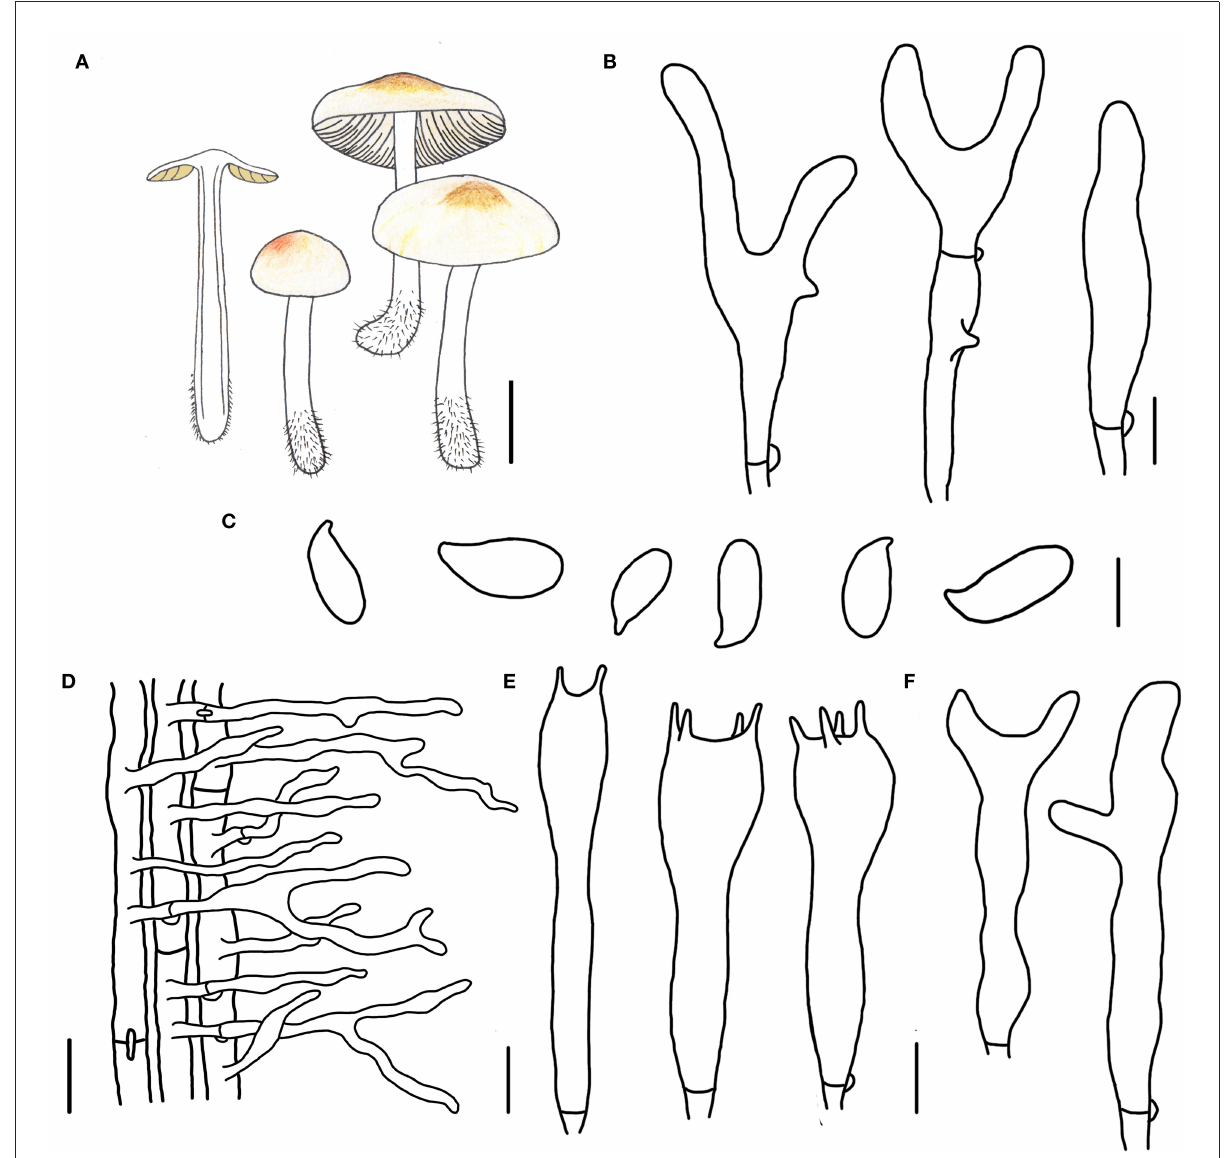
FIGURE3 Morphological characteristics of Gymnopus epiphyllus (HMJAU 60990, holotype). (A) Basidiomata; (B) Pileipellis elements; (C) Basidospores; (D) Caulocysidia; (E) Basidia; (F) Cheilocystidia; Scale bars: 1cm (A) ; 10 µ m (B) ; 5 µ m (C,E,F) ; 20 µ m (D) .